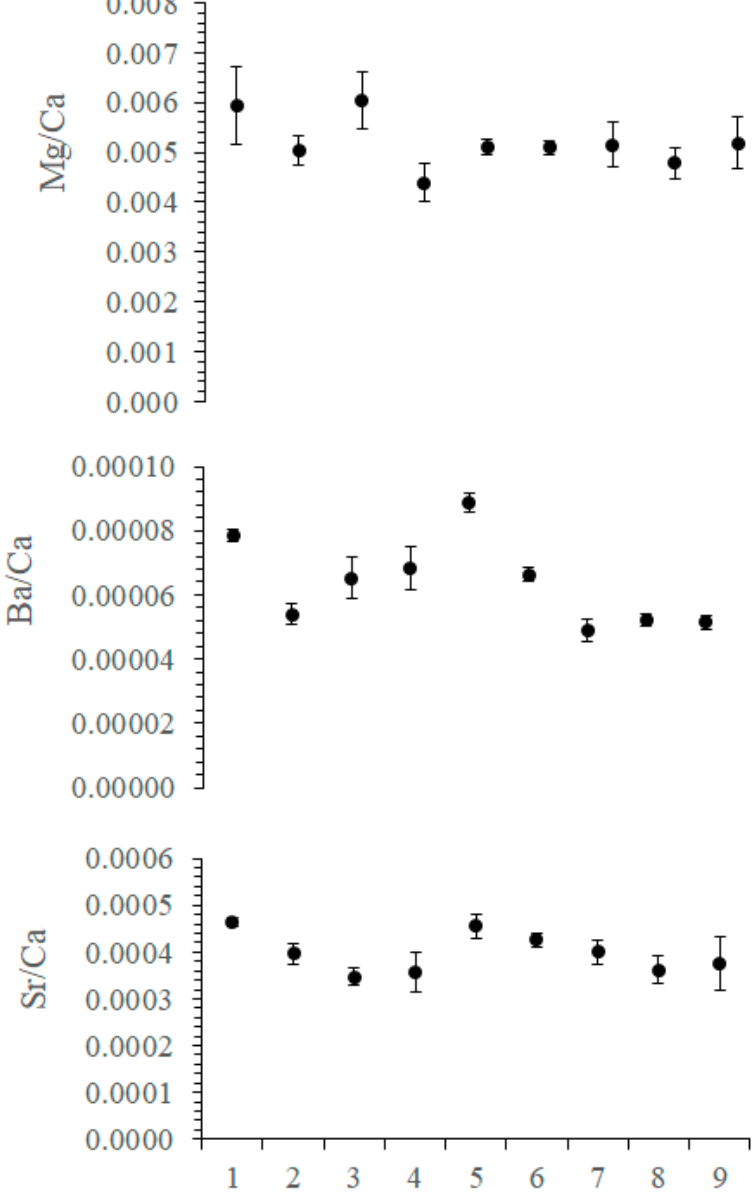
Figure 3. Element concentrations (µg/g) of nine specimens of Pneophyllum cetinaensis . X axes identify the specimens. The graph shows the average ± SD of all specimens.